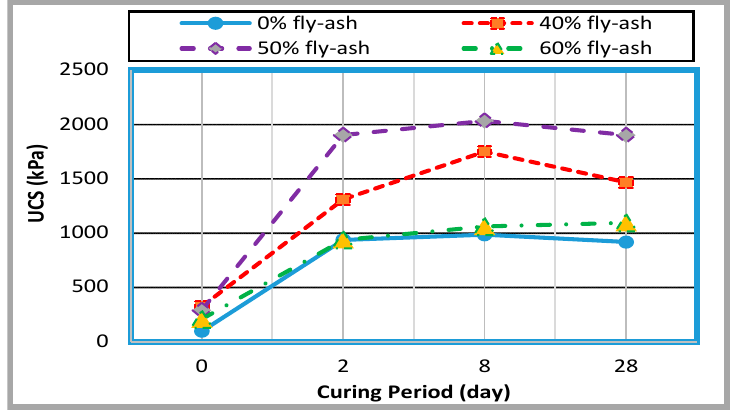
Figure 6. Variation of UCS with curing